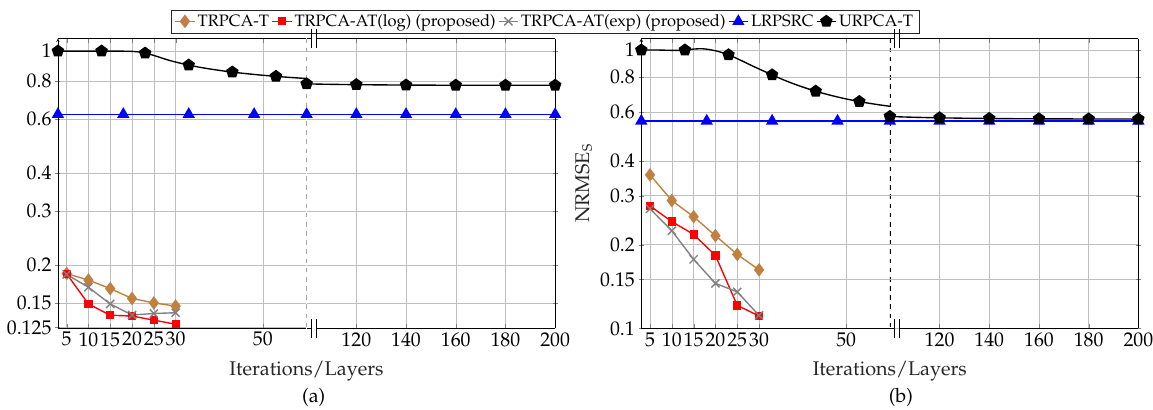
Figure 13. Average NRMSE of low-rank ( a ) and sparsity ( b ) contributions of SFCW Radar model for K / MN = 20% with M = N = 30 for ADMM-based trained RPCA with thresholding (TRPCA-T), proposed ADMM-based trained RPCA with adaptive thresholding based on logarithm heuristic (TRPCA-AT(log)), proposed ADMM-based trained RPCA with adaptive thresholding based on expo- nential heuristic (TRPCA-AT(exp)), low-rank plus sparse recovery with convex relaxation (LRPSRC), and ADMM-based untrained RPCA with thresholding